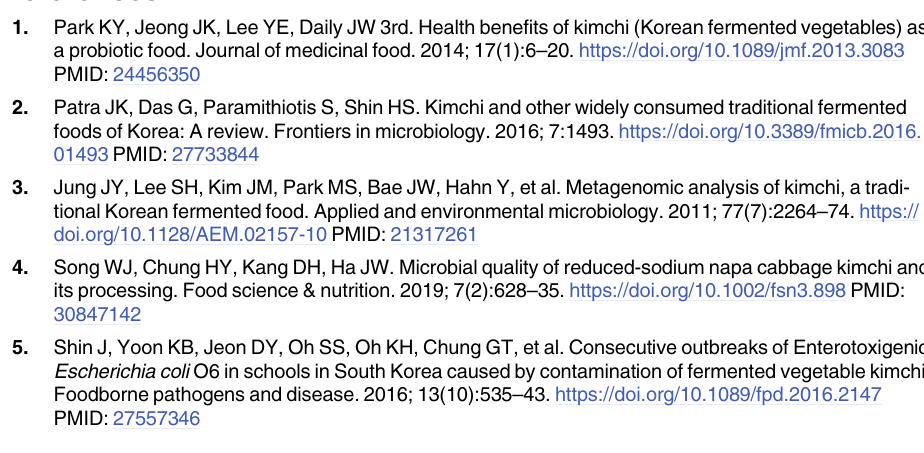
S2 Table. CRISPR loci of P . agglomerans